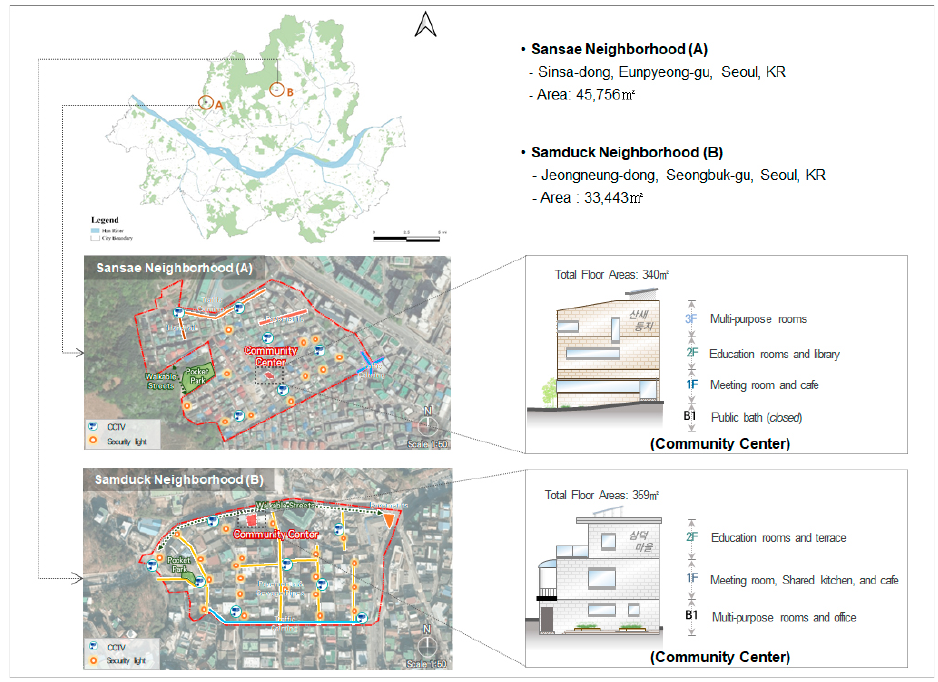
Figure 2. The location of community centers in Sansae and Samduck neighborhoods, Seoul.